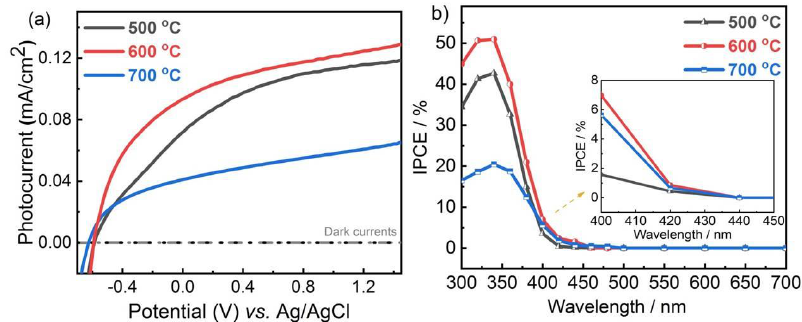
Figure 6. ( a ) Linear sweep voltammetry scans (LSV) of nanotubes measured in 1 M NaOH solution, under 1 sun illumination (100 mW cm − 2 , AM1.5G) and ( b ) IPCE (%) spectra of TiO 2 nanotubes measured at 0.5 V vs. Ag/AgCl.